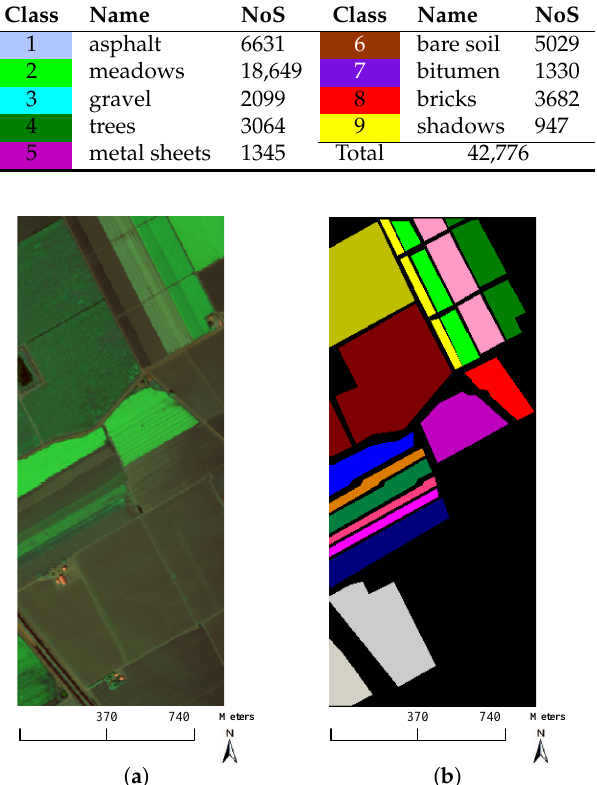
Table 2. NoS used in the University of Pavia data.